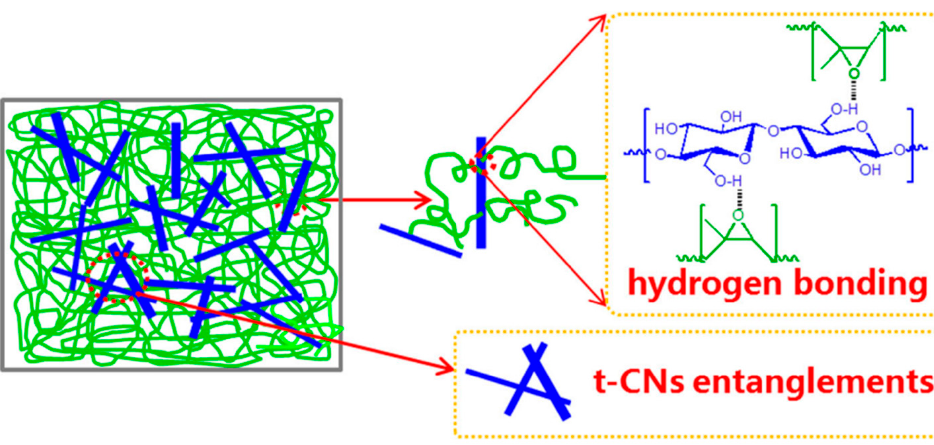
Figure 14. Schematic illustration of the CNC/ENR nanocomposite structure (reproduced with permission from [150]).